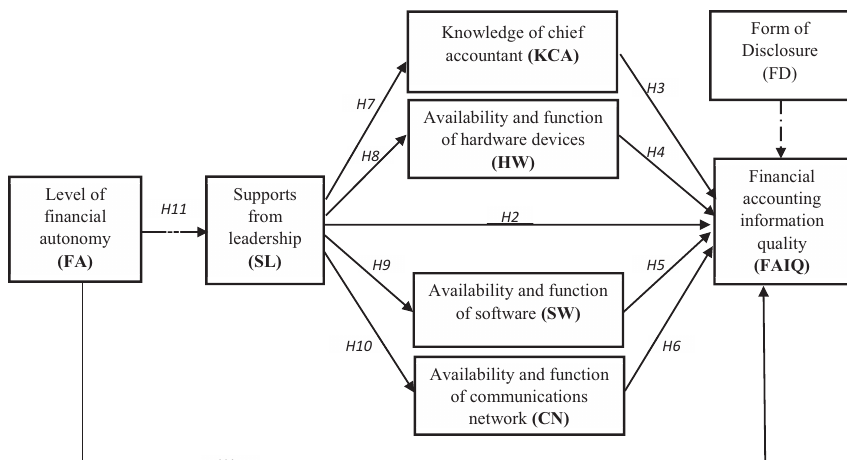
Figure 1. The research